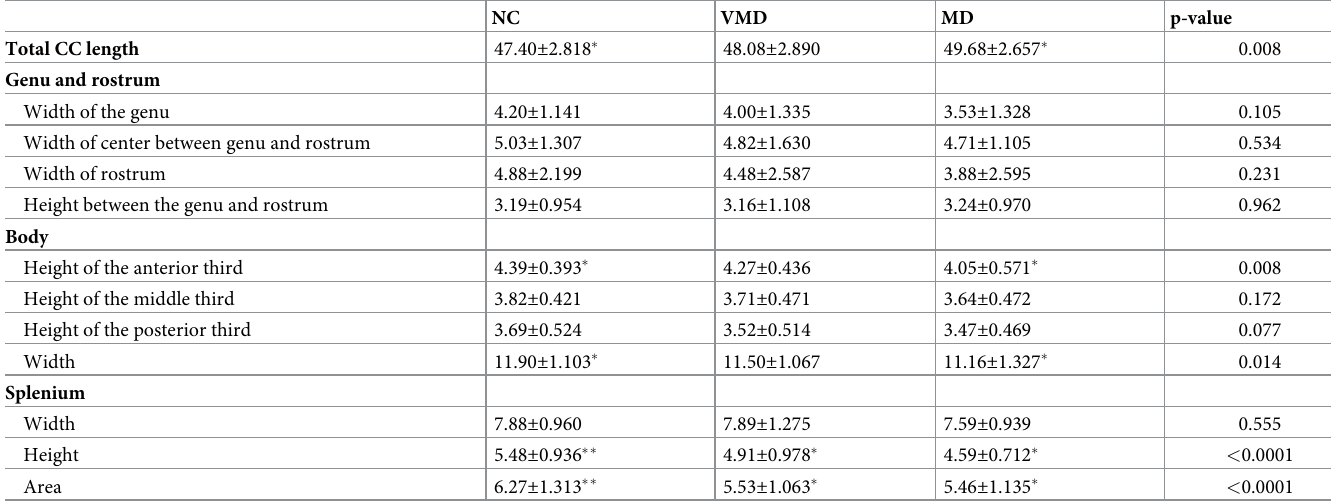
Table 2. Group differences of MRI measurements.